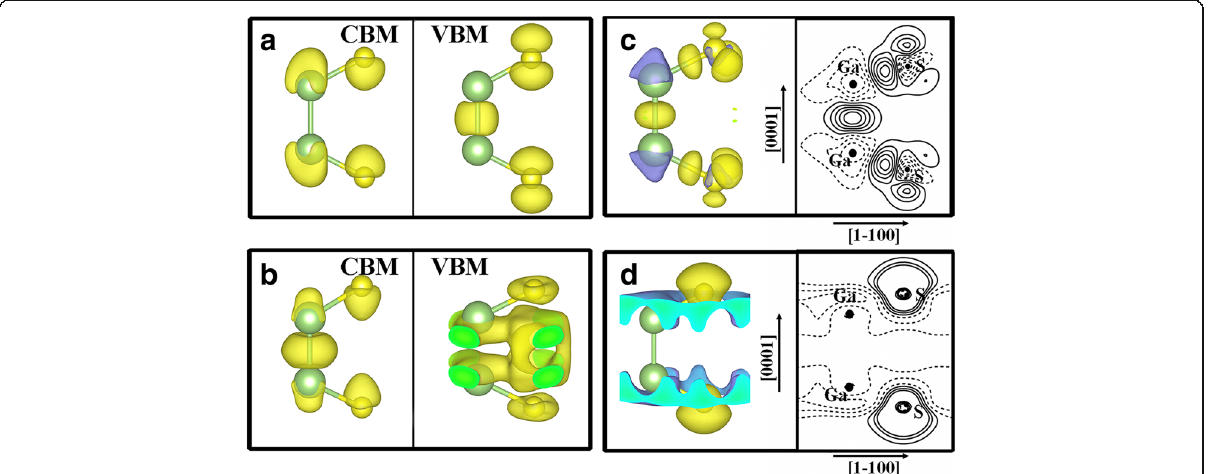
Fig. 5 Partial density of states of the CBM and VBM of GaS ML without ( a ) and with ( b ) an external electric field of 8 V/nm, respectively. Spatial charge density difference and the vertical section along (1-100) plane of GaS ML without ( c ) and with ( d ) an external electric field of 8 V/nm, respectively. The positive and negative density (contours) are, respectively, shown with yellow ( solid lines ) and blue ( dashed lines ) colors, and the contour interval is 0.005 eÅ −